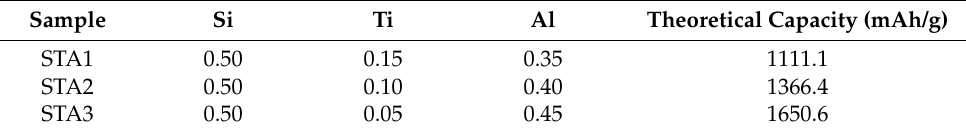
Table 1. Si, Al, and Ti molar ratios for the ternary alloys and their theoretical capacities. Sample Si